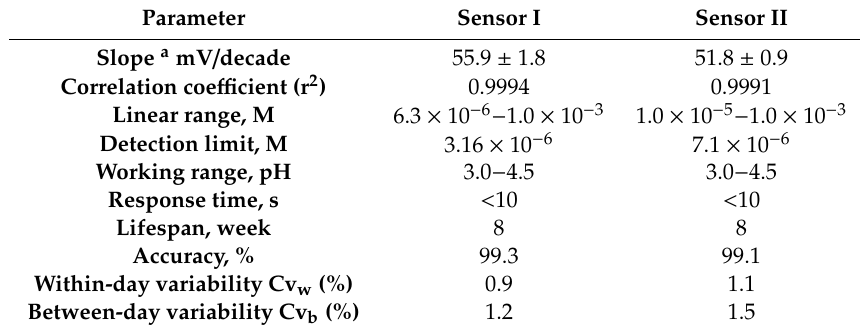
Table 1. Performance characteristics of citicoline membrane-based electrodes in 50 mM acetate bu ff er, pH